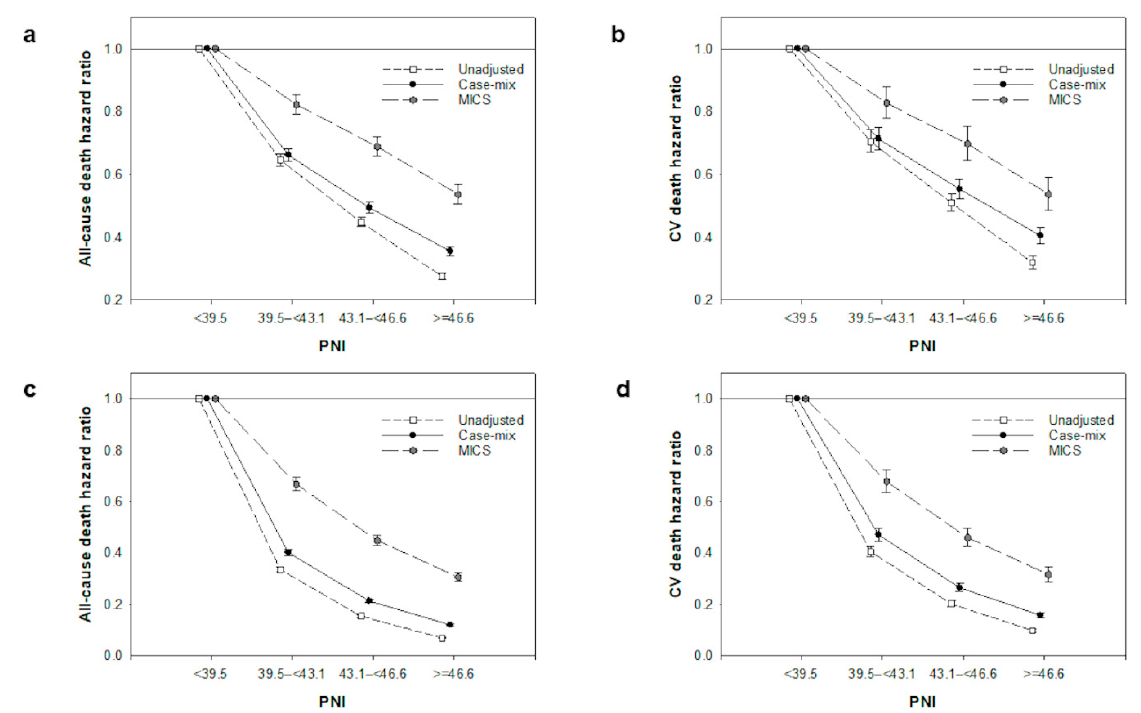
Figure 3. Association of prognostic nutritional index (PNI) with all-cause and cardiovascular mortalities using the Cox regression model adjusted for baseline variables ( a , b ) and time-varying variables ( c , d ) in the entire cohort of 101,616 patients undergoing hemodialysis. Hazard ratios for mortality in the Cox regression models with three-level adjustments are compared between quartiles of PNI (reference: PNI < 39.5). Error bars show 95% confidence intervals of hazard ratios. Abbreviations: PNI, prognostic nutritional index; MICS, malnutrition–inflammation complex syndrome; CV, cardiovascular.